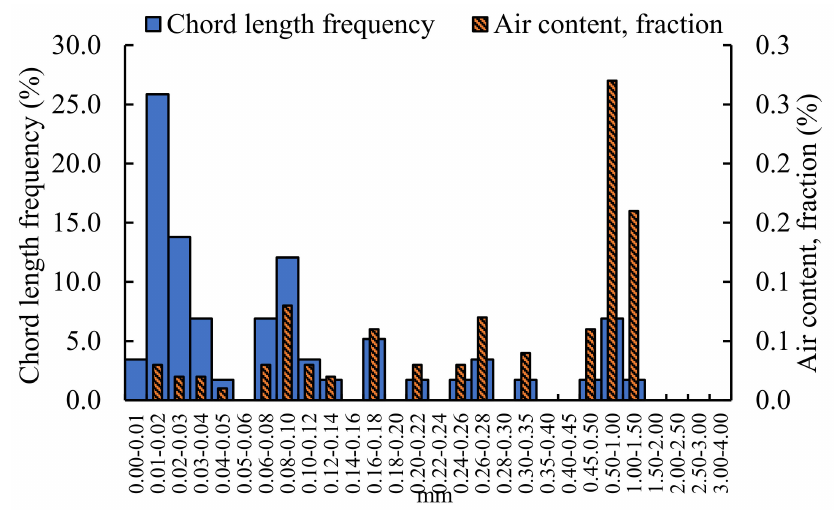
Figure 7. Analysis of pores structure of grouting material mixed with 1.6% NM.